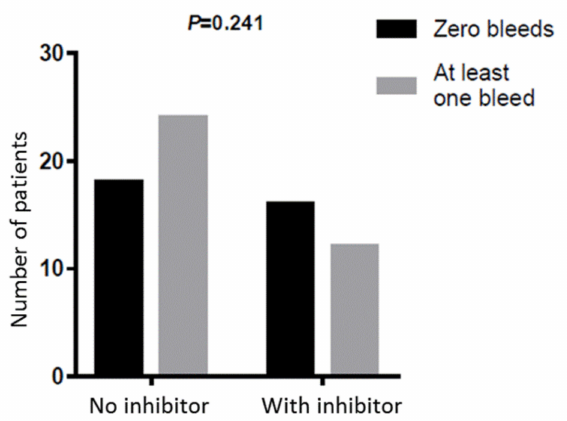
Figure 4. Comparison of spontaneous bleeding episodes in patients without vs. with FVIII inhibitors during 18-month emicizumab prophylaxis. The bleeding episodes were presented as counts. The proportions of bleeding episodes in either subgroup were compared using the Chi-square test. The resulting P value is shown in the graph.